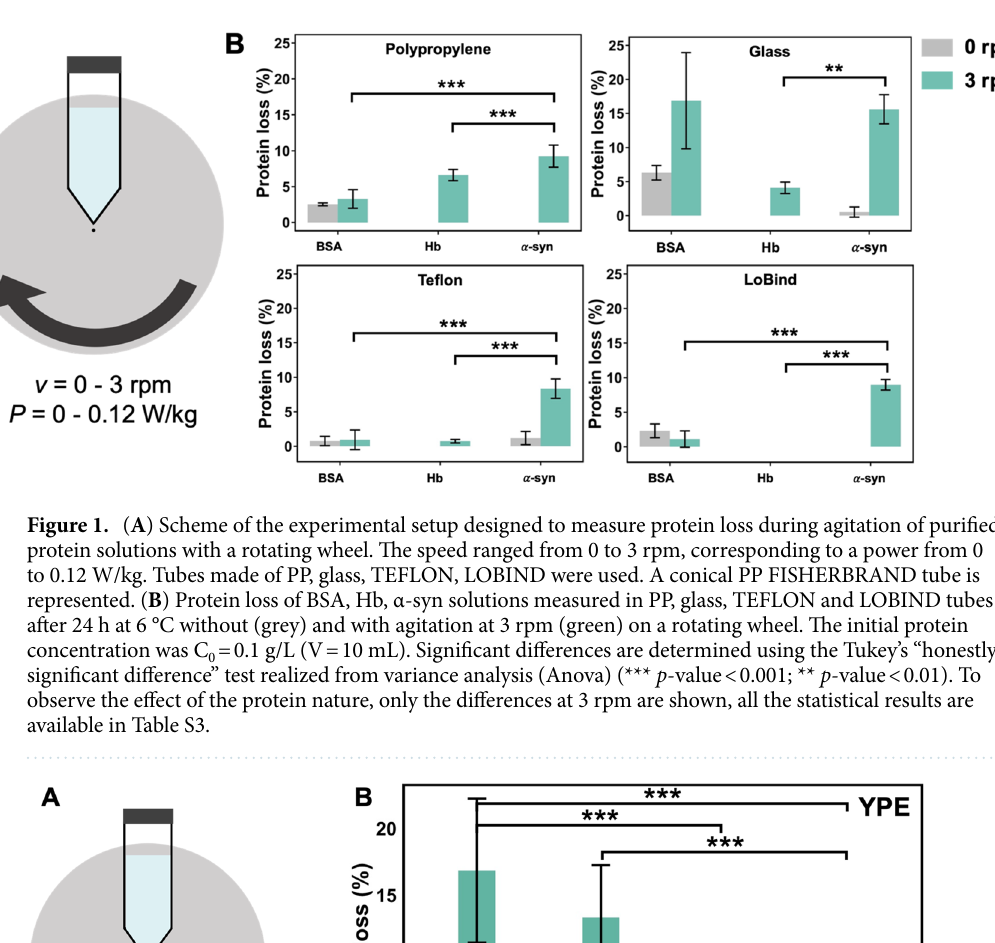
after moderate agitation of the protein solution for 24 h at 6 °C in PP, glass, TEFLON, and LOBIND tubes on a rotating wheel at a speed of 3 to 30 rpm. The YPE was treated with a cocktail of protease inhibitors to prevent enzymatic protein degradation. The initial and final protein concentration was measured using UV spectroscopy and the percentage of lost protein calculated (Fig. 2). The maximum protein losses were observed for PP and glass tubes. A significant protein loss was also observed in TEFLON and LOBIND tubes. Higher levels of protein loss were measured for YPE compared to Hb, BSA and α-syn on PP. Significant protein losses were observed in all agitation conditions to a level that cannot only be due to protein adsorption on the material surfaces. Indeed, the maximum losses measured in glass vials correspond to ten times the higher mass reported by our group for covering silica surfaces using the same YPE protein extract solution 17 . Furthermore, the protein losses were comparable between LOBIND plastic (7 ± 3%) expected to be non-adsorbing for proteins 20,21 , and PTFE (5 ± 3%) expected to be a strong binder because of hydrophobic interactions 22,23 . Measured losses did not simply follow the values of the solutions/material’s